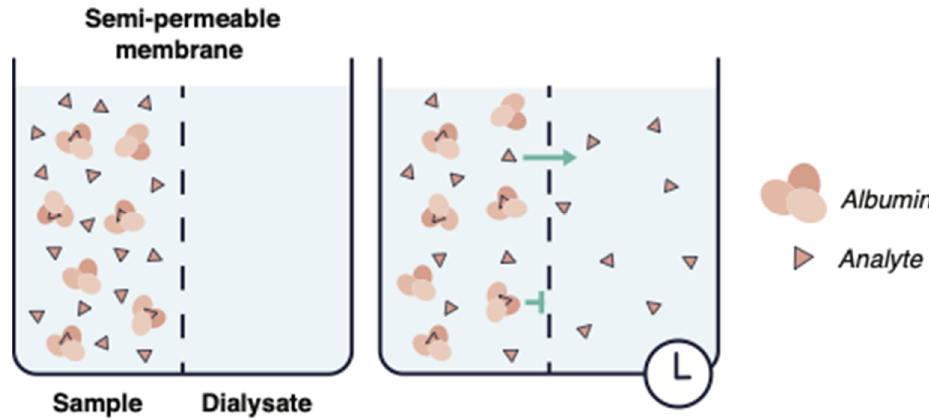
Figure 2. Overview and principle of equilibrium dialysis. Another common method for quantifying the free concentration of a drug in plasma is ultrafiltration [57,58]. An ultrafiltration (UF) system consists of two chambers that are divided by a semi-permeable filter, which has different molecular weight capacities for protein filtration. UF is based on the principle of separation of small volumes of protein-free phase, by exerting a centrifugal force to a solution with both proteins and the substance of interest that is present in the upper compartment of a special UF device [57,58]. After separation by centrifugation, the free drug concentration is determined from the protein- free ultrafiltrate located in the lower compartment of the UF device. fluid of various tissues, and quantification of PPB in blood [59]. Microdialysis is based on the principle of diffusion of molecules along their concentration gradient between two compartments [60]. To determine PPB, a microdialysis probe with a semi-permeable membrane at its tip is inserted into a blood vessel [58] (Figure 3). Afterwards, a dialysate buffer is flushed through the probe and the unbound fraction of a drug in plasma diffuses through the semi-permeable membrane. Larger molecules, including proteins such as albumin, cannot pass through the membrane. The maximum size of proteins that can diffuse depends on the molecular weight limit of the semipermeable membrane [61]. The collected microdialysate samples can then be analyzed